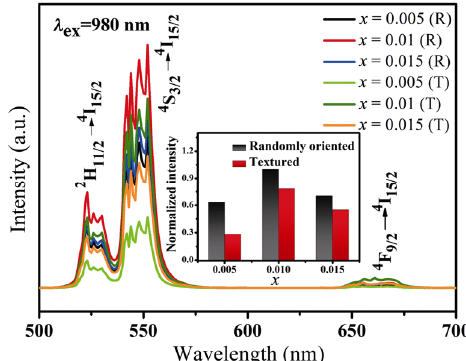
Fig. 5 Up-conversion PL emission spectra of randomly oriented and textured x Er–BCTZ thick films under the excitation of 980 nm. The inset shows the change of normalized PL intensity (at 550 nm) as a function of x